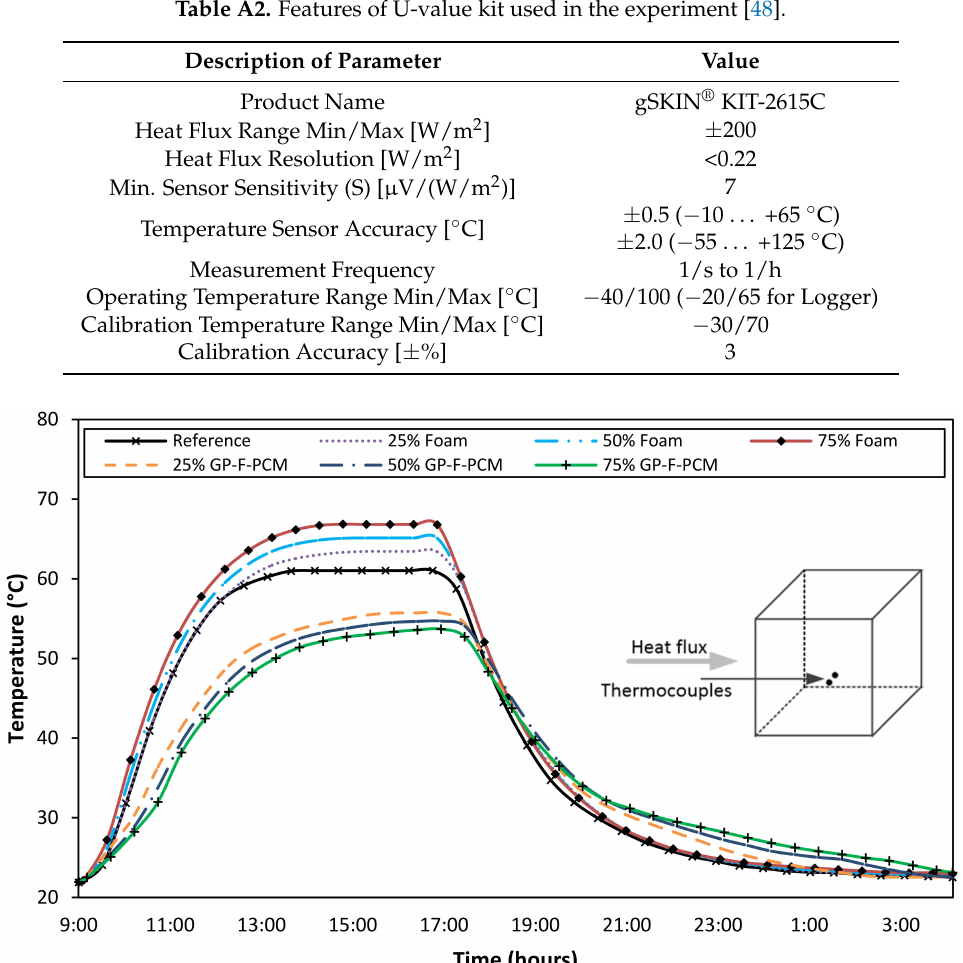
Table A2. Features of U-value kit used in the experiment [48].